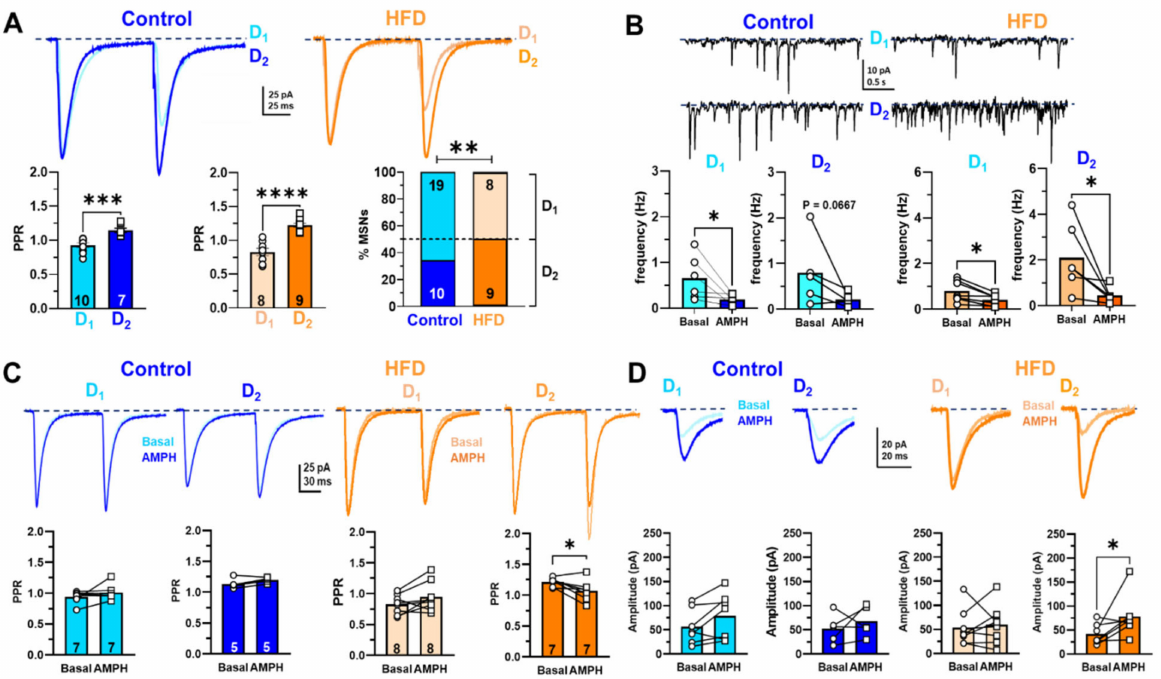
Figure 2. Changes in the NAcc glutamatergic synaptic transmission of control and HFD male rats. ( A ) Representative PPR average traces were recorded in D 1 -like MSNs and D 2 -like MSNs of the control group (light and dark blue, respectively) and in D 1 -like MSNs and D 2 -like MSNs of HFD (light and dark orange, respectively). Summary graphs of PPR average values in control ( left) and HFD ( middle ) groups, showing depression in D 1 -like MSNs and facilitation in D 2 -like MSNs in both groups. The proportion of D 1 -like and D 2 -like cells in control and HFD groups ( right ). ( B ) Representative traces of spontaneous synaptic activity were recorded in D 1 (upper traces) and D 2 ( lower traces)-like MSNs of control ( left ) and HFD ( right ) in basal conditions. The lower panel shows the summary graphs of spontaneous EPSC frequency in basal and AMPH conditions (0.1 µ M) for two cell types, comparing the mean values between groups. ( C ) Superimposed PPR average traces were recorded in representative D 1 -like MSNs ( upper ) and D 2 -like MSNs ( lower ) control cells in basal and in the presence of AMPH (light and dark blue, respectively). Summary graphs of PPR in control ( left ) in D 1 -like and D 2 -like cells, comparing the average value in basal and AMPH conditions. Summary graphs of PPR in HFD ( left ) in D 1 -like and D 2 -like cells, comparing the average value in basal and AMPH conditions. ( D ) Average EPSC evoked by a single pulse recorded in single D 1 -like and D 2 -like cells of control rats, superimposing the traces recorded in basal and AMPH conditions ( upper panel). Summary graphs of average values of EPSC amplitude in control in D 1 -like and D 2 -like cells, comparing the average value in basal and AMPH conditions ( lower panel). Average EPSC evoked by a single pulse recorded in single D 1 -like and D 2 -like cells of HFD rats, superimposing the traces recorded in basal and AMPH conditions ( upper panel). Summary graphs of average values of EPSC amplitude in D 1 -like and D 2 -like cells, comparing the average value in basal and AMPH conditions ( lower panel). Data are expressed as means ± SEM (mean standard error), and the statistical analysis used were t -test Welch one-tailed (Figure 2A), Mann–Whitney two-tailed two-way (Figure 2B), and Wilcoxon two-tailed (Figure 2C,D) (* p <0.05; ** p <0.01; *** p <0.001; **** p